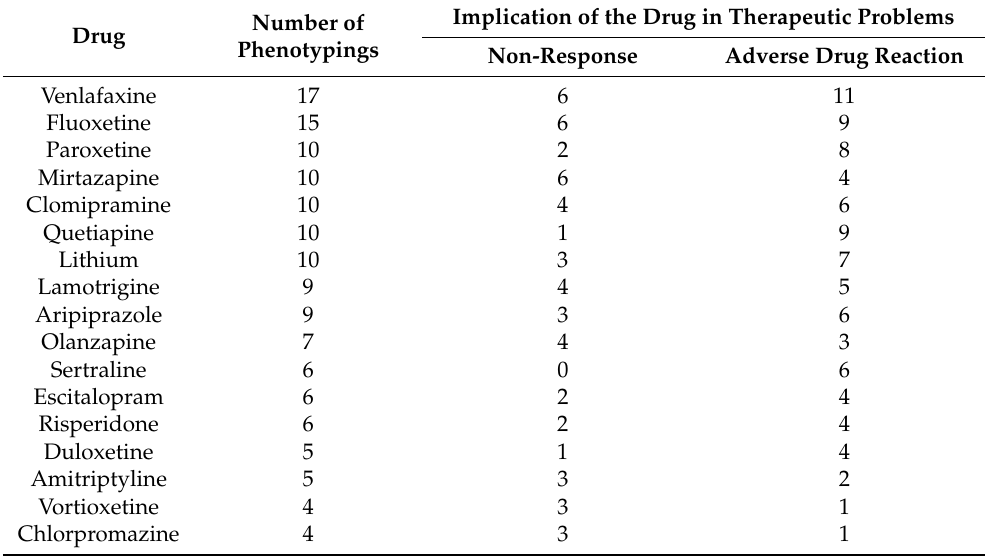
Table 2. Drugs most implicated in the therapeutic problems that led to a phenotypic assessment. Number of Drug